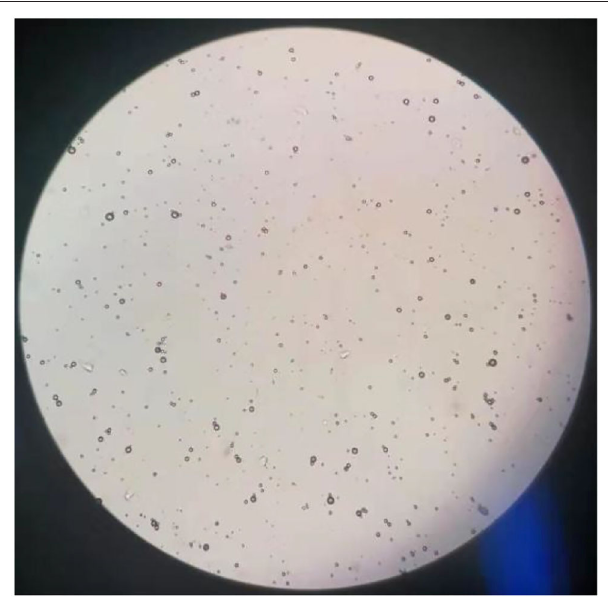
FIGURE 2 | Microscopic images on microcapsule particle size prepared by in situ polymerization (100 × ).